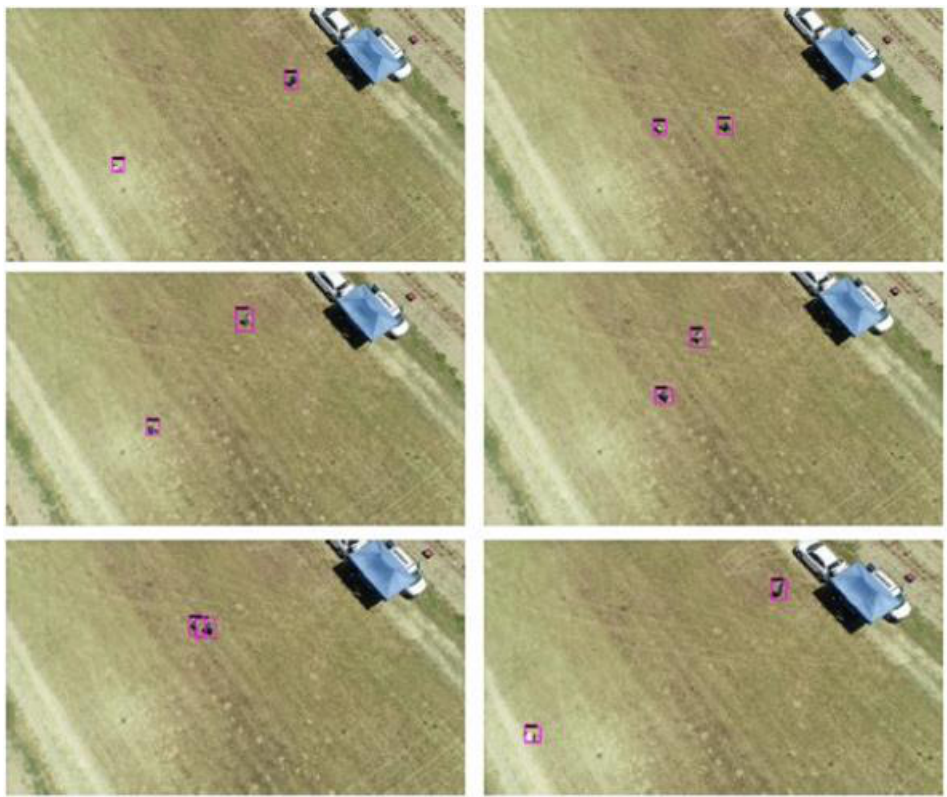
Figure 34. Inference results sequence for two people.